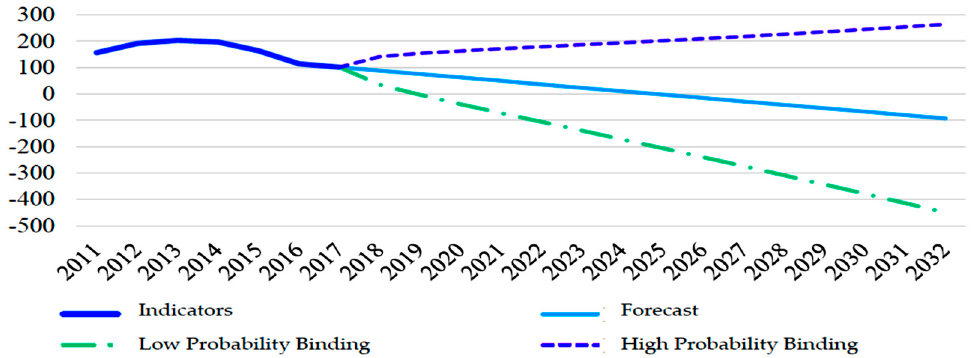
Figure 5. Forecast of revenues of Oil Companies 2018-2032, billions of dollars. Source: calc. by author by data [56].